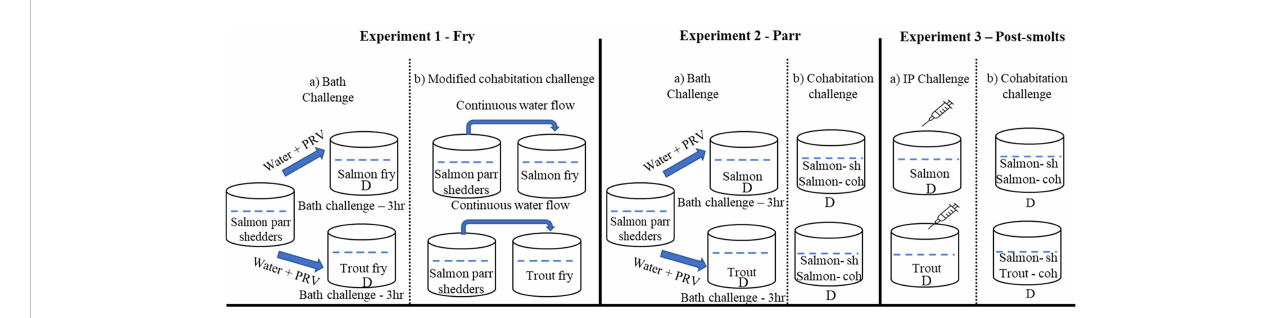
FIGURE 1 Experimental setup and challenge methods used in the study. *D denotes tanks in